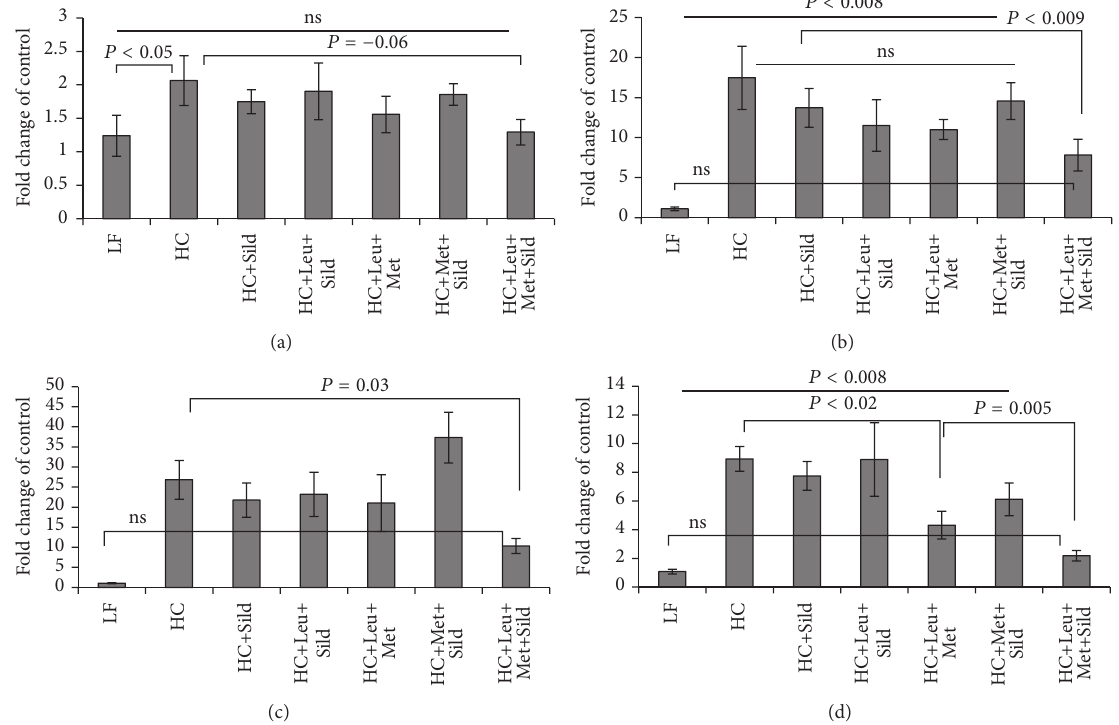
Figure 9: Sild-Met-Leu effects on liver inflammatory marker in mice. Mice were fed a low-fat (LF) diet or high-fat atherogenic (HC) diet for 6 weeks and then randomized to the indicated treatment groups for an additional 6 weeks. Gene expression of (a) interleukin- (IL-) 1 beta, (b) tumor necrosis factor- (TNF-) alpha, (c) monocyte chemotactic protein- (MCP-) 1, and (d) plasminogen activator inhibitor- (PAI-) 1 was measured in liver extracts. Data are expressed as mean ± SEM of fold change of control ( 𝑛 = 6 ). Sild: sildenafil, Met: metformin, Leu: leucine.